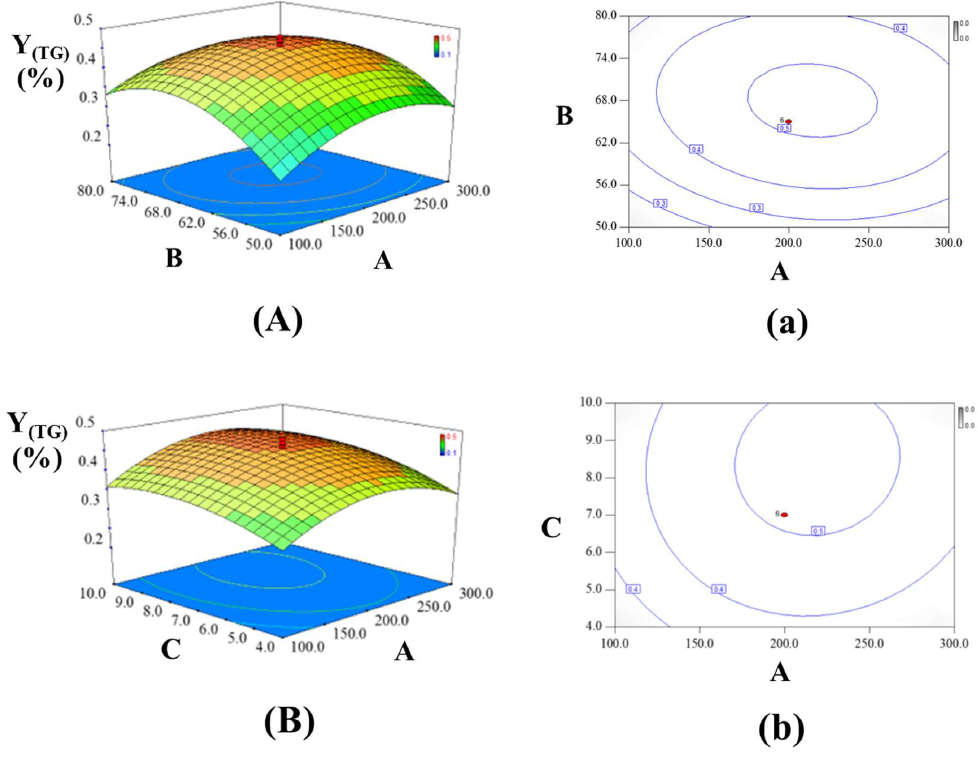
Figure 3. Three-dimensional contour plots showing the experimental factors and their mutual interactions: ( A ) effect of ultrasound-assisted extraction (UAE) power and EtOH% on the yield of flavonoids; ( B ) effect of UAE power and the amount of cellulase on the yield of flavonoids, and ( C ) effect of EtOH% and the amount of cellulase on the yield of flavonoids. Two-dimensional contour plots showing the experimental factors and their mutual interactions: ( a ) effect of ultrasound-assisted extraction (UAE) power and EtOH% on the yield of flavonoids; ( b ) effect of UAE power and the amount of cellulase on the yield of flavonoids, and ( c ) effect of EtOH% and the amount of cellulase on the yield of flavonoids.